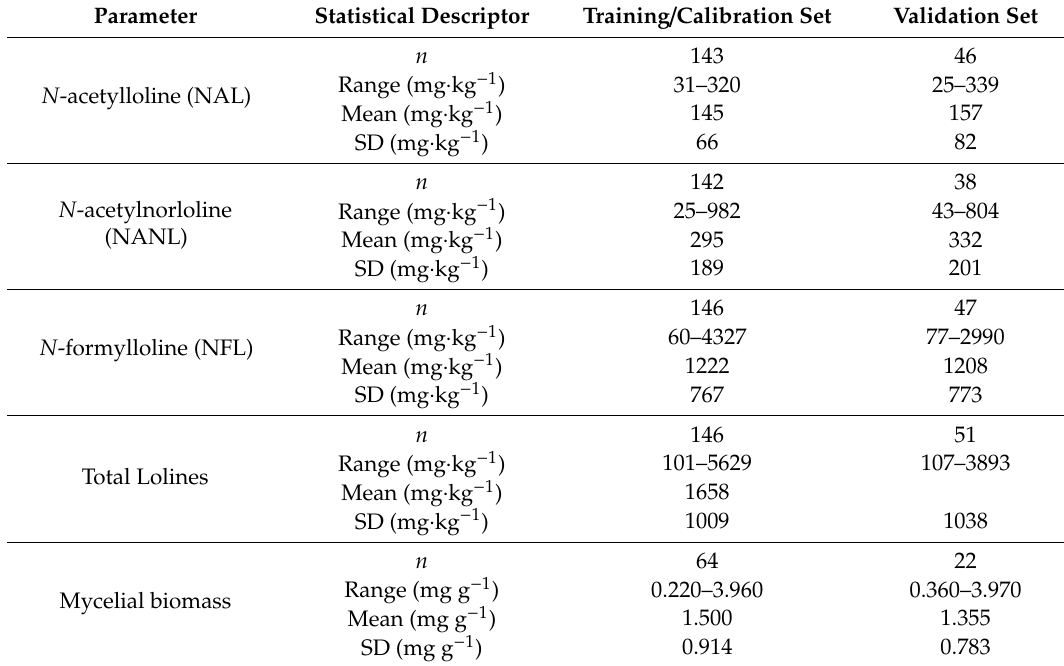
Table 1. Characteristics and number of the meadow fescue samples ( n ) used in the development of near infrared spectroscopy (NIRS) models for quantification of Loline alkaloids and mycelial